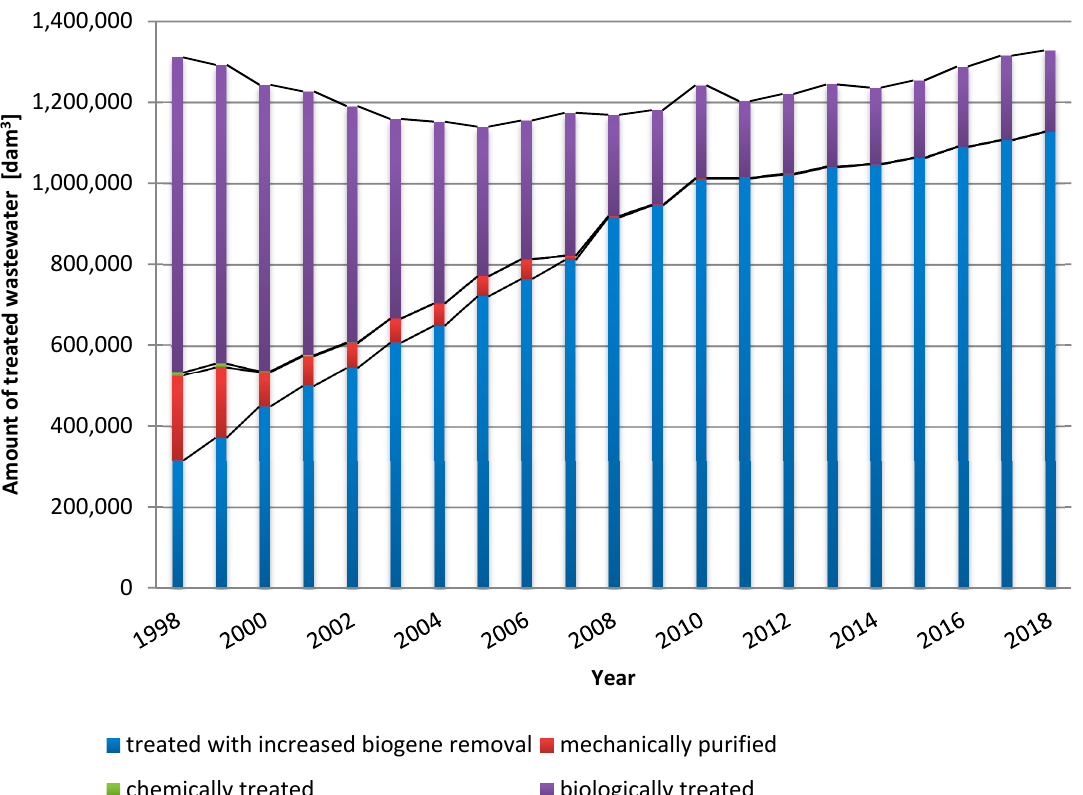
Figure 1. Change in the amount of municipal wastewater treated in Poland in 1998–2018, broken down by treatment method—own study based on data from [7].